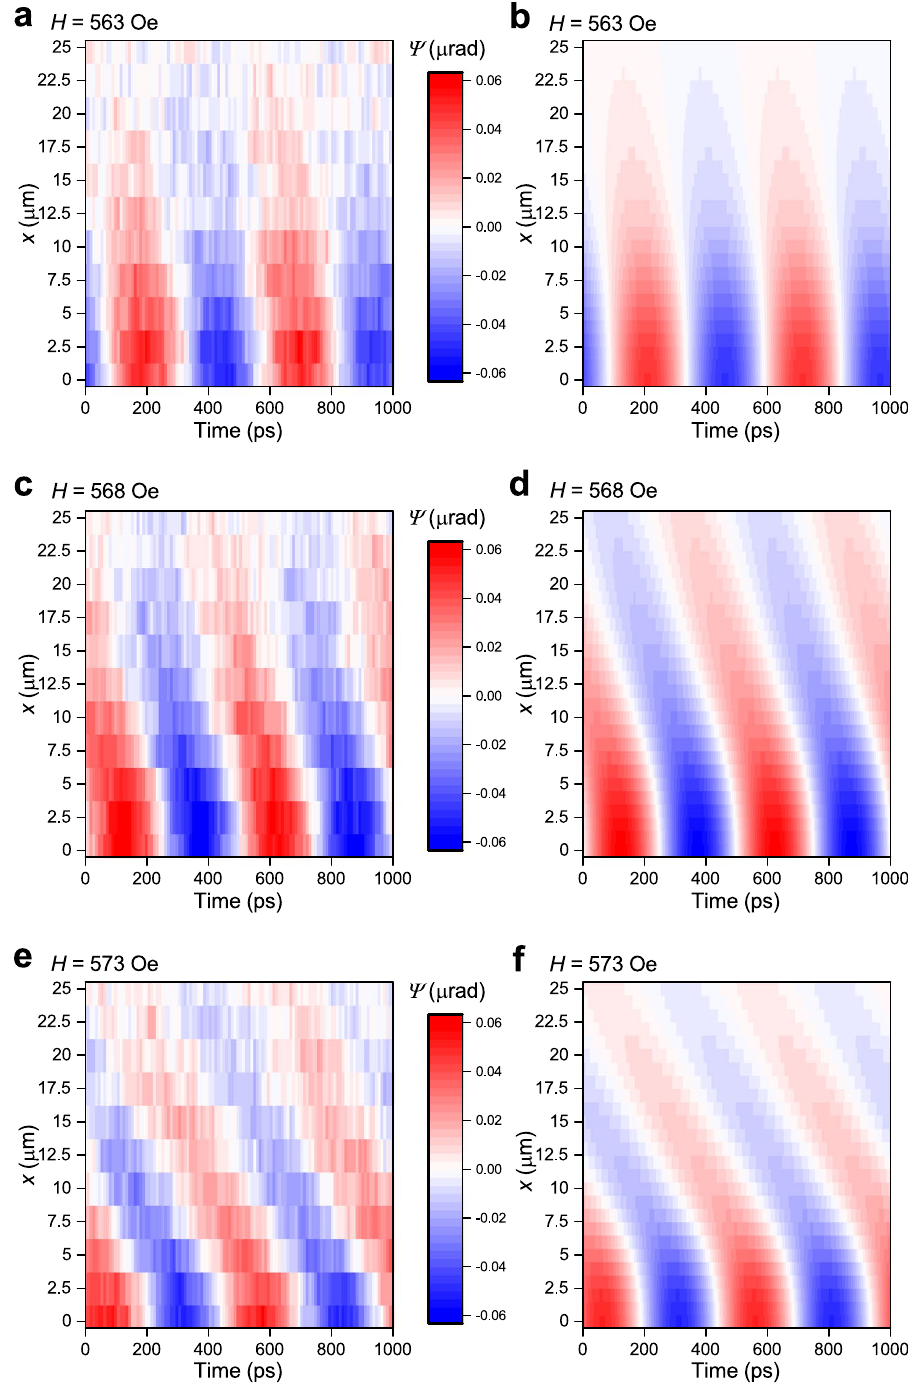
Figure 2. Influence of the external magnetic field on the propagation of SWs excited by the 1GHz-laser in sample-A (case-I). Color contour plots of experimentally measured ( a,c,e ) and calculated ( b,d,f ) oscillations of the out-of-plane magnetization component in time and space, detected through the Faraday rotation Ψ ( x , t ) at three different values of the external magnetic field H = 563 Oe ( a,b ), 568 Oe ( c,d ), and 573 Oe ( e,f ). For the calculations we use the Gilbert damping constant α = 4 × 10 − 3 which provides the best correspondence with the experimental